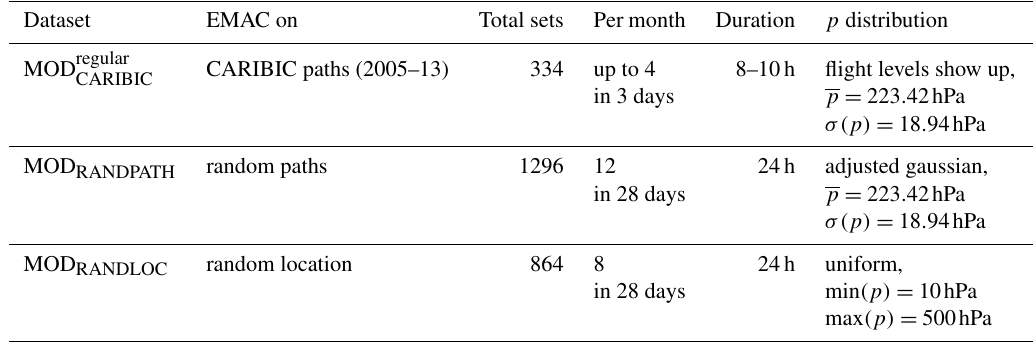
, MOD RANDPATH and MOD RANDLOC . CARIBIC